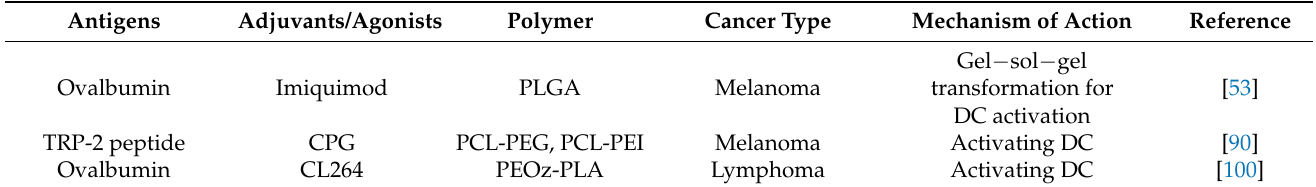
Table 8. Polymers used for codelivery of antigens and